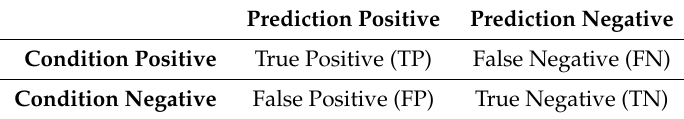
Table 2. Confusion